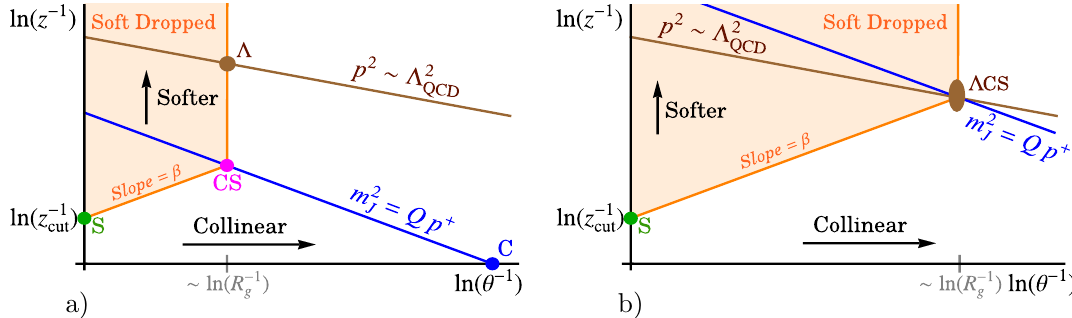
Figure 3 . Modes appearing in the soft drop factorization formula for jets initiated from massless quarks or gluons. Panel a) shows a m J value in the operator expansion region, while panel b) shows a m J in the nonperturbative region. Here z is the energy fraction relative to the total jet energy, and (cid:18) is the polar angle relative to the jet-axis. The hard modes H at z (cid:24) 1 and (cid:18) (cid:24) 1 are not shown.